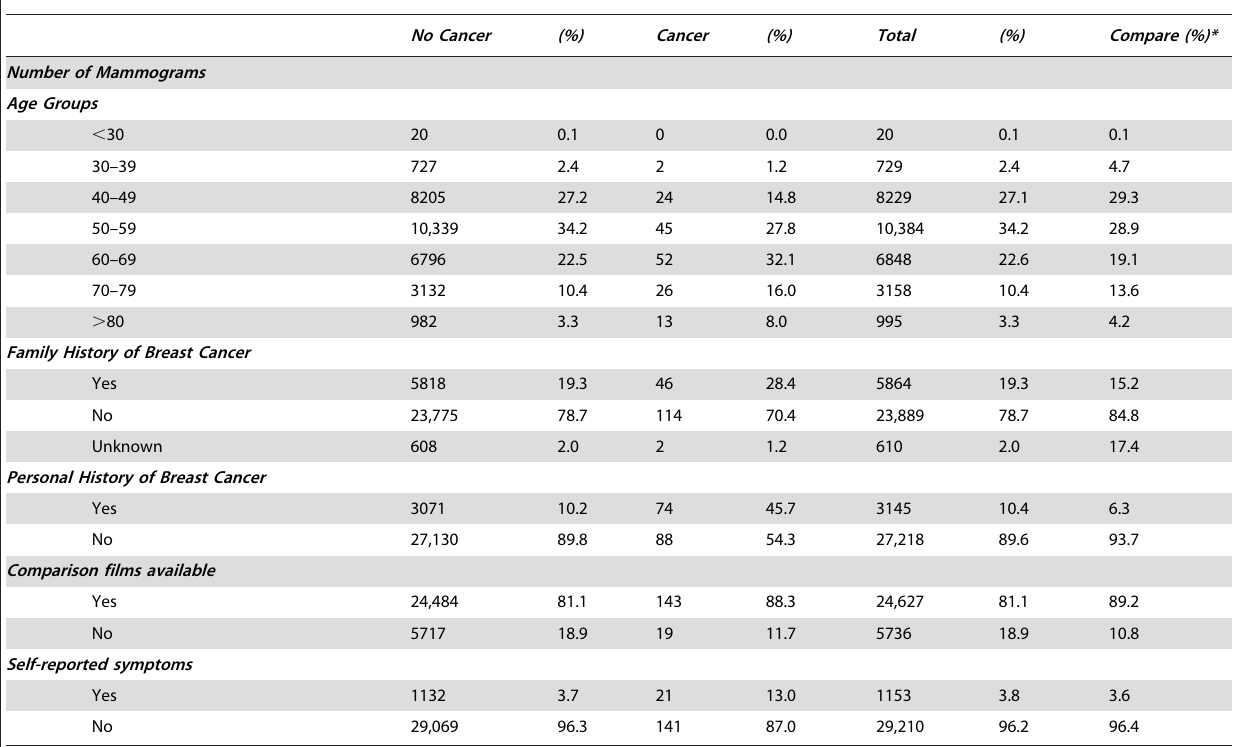
Table 2. Distribution of study